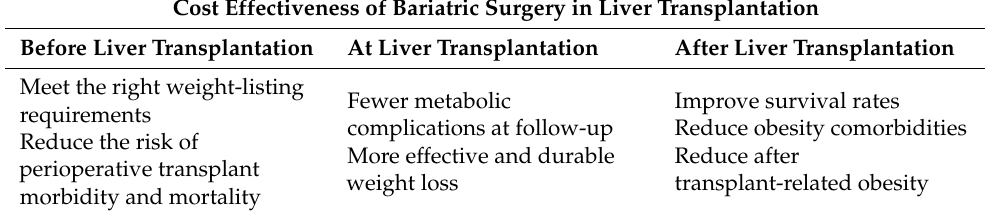
Table 2. Cost-effectiveness of bariatric surgery in liver transplantation. Cost Effectiveness of Bariatric Surgery in Liver